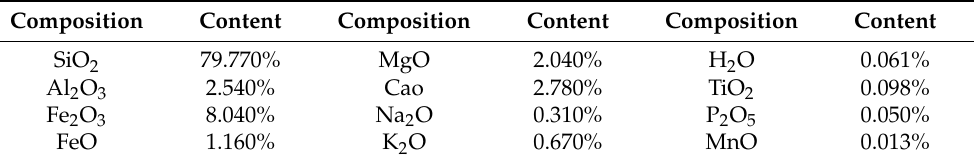
Figure 2. Particle size distribution of the tailings samples used in the tests. Table 1. Chemical component of unclassified tailings.